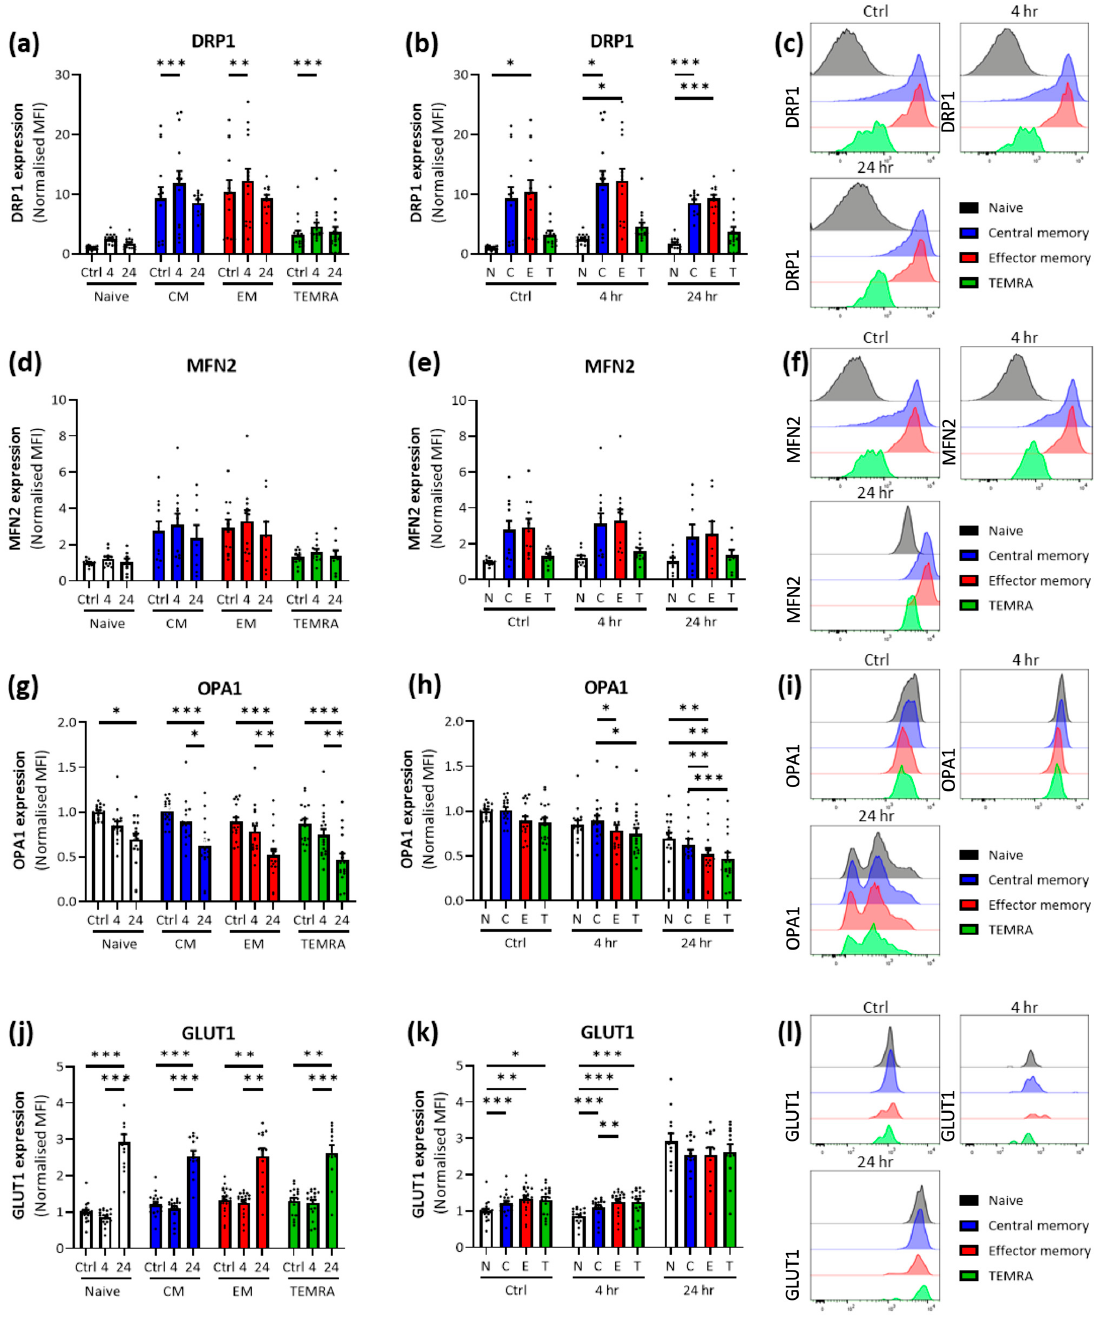
Figure 2. Flow cytometry analysis of proteins controlling mitochondrial dynamics and GLUT1 in CD4+ T cells. ( a ) Change in DRP1 expression with OKT3 stimulation ( n = 17); ( b ) comparison of DRP1 expression between subsets ( n = 17); ( c ) histogram of DRP1 expression in a representative sample; ( d ) change in MFN2 expression with OKT3 stimulation ( n = 17); ( e ) comparison of MFN2 expression between subsets ( n = 17); ( f ) histogram of MFN2 expression in representative sample; ( g ) change in OPA1 expression with OKT3 stimulation ( n = 18); ( h ) comparison of OPA1 expression between subsets ( n = 18); ( i ) histogram of OPA1 expression in a representative sample; ( j ) change in GLUT1 expression with OKT3 stimulation ( n = 19); ( k ) comparison of GLUT1 expression between subsets ( n = 19); ( l ) histogram of GLUT1 expression in a representative sample. (Mean+SEM; two-way repeated measures ANOVA with Tukey post hoc analysis; * p < 0.05 ** p < 0.01 *** p < 0.001; expression normalized to unstimulated naïve